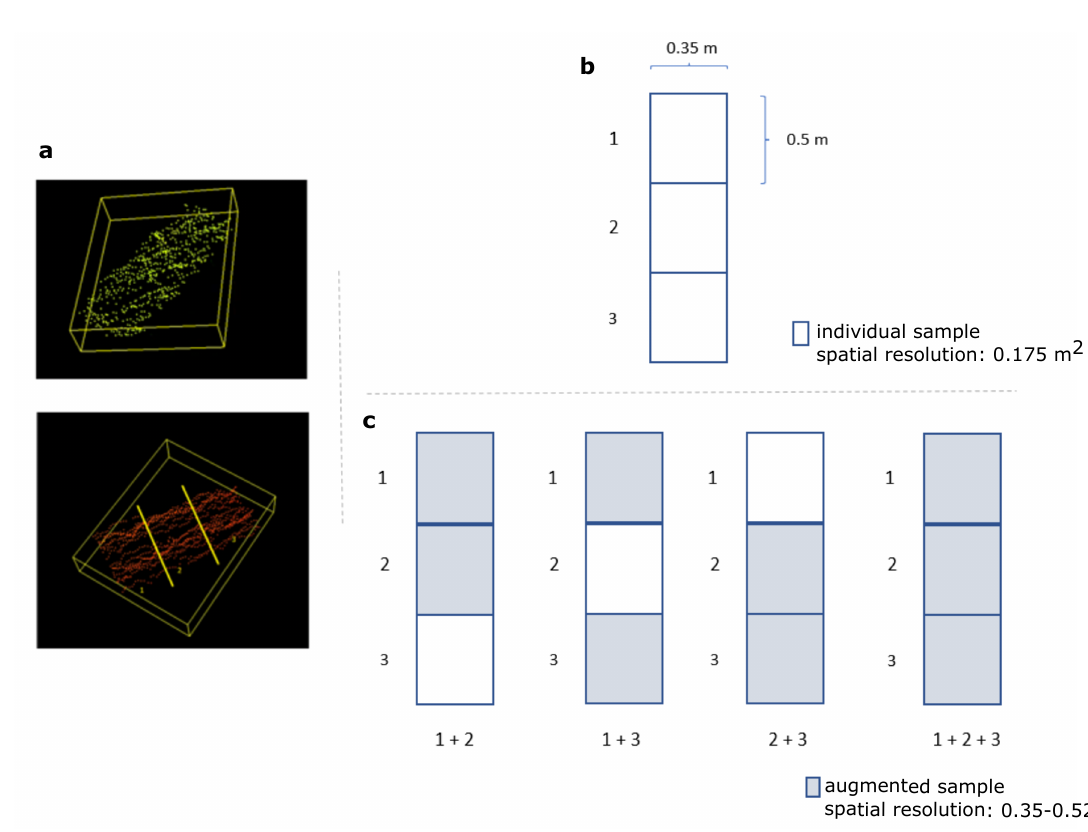
Figure 6. The generation of the augmented datasets: ( a ) the partitioning of the individual LiDAR samples into three adjacent parts; ( b ) the three original adjacent AGB samples (individual size: 0.175 m 2 ); ( c ) the shaded area represents each augmented sample (size: 0.35 m 2 –0.52 m 2 ). The